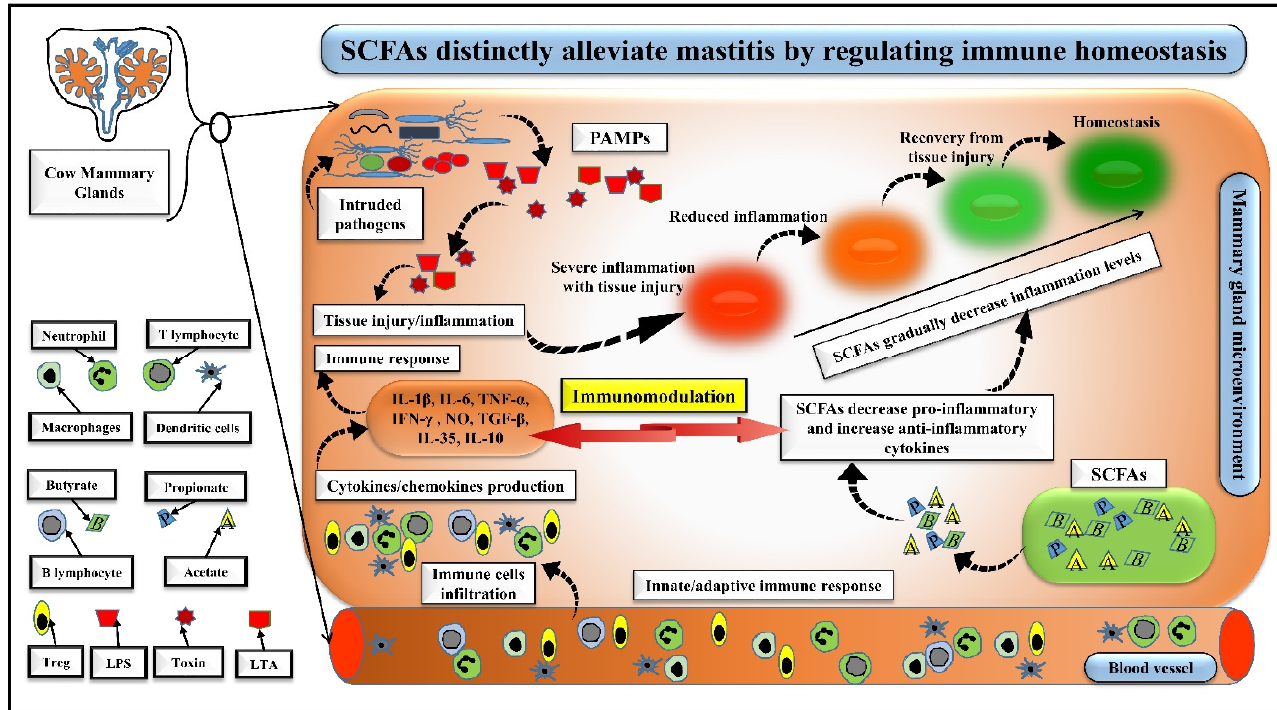
Figure 3. SCFAs distinctly alleviate mastitis by regulating immune homeostasis.